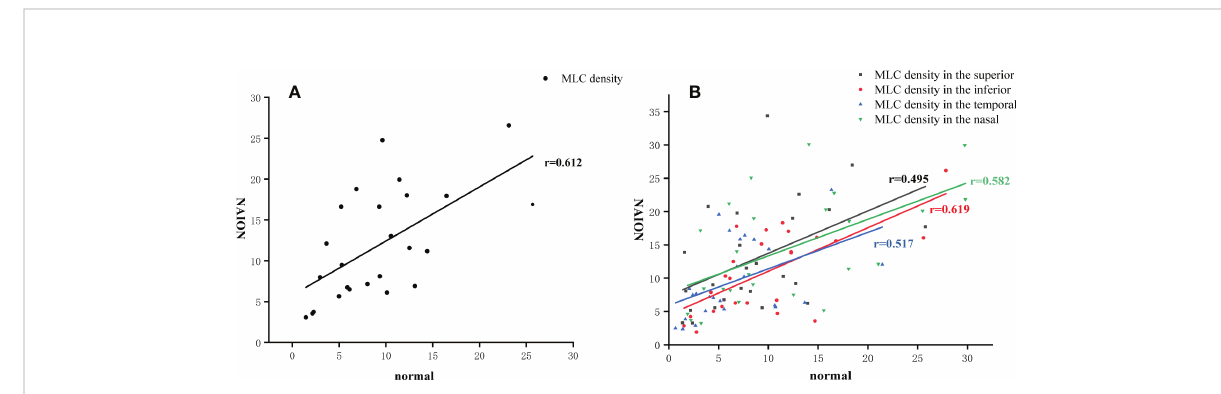
FIGURE 4 MLC density in the affected eye correlated to the fellow eye. (A) The positive correlation of MLC density in the total area between the NAION eyes and the fellow eyes. (B) The positive correlation of MLC density in four subregions between the NAION eyes and the fellow